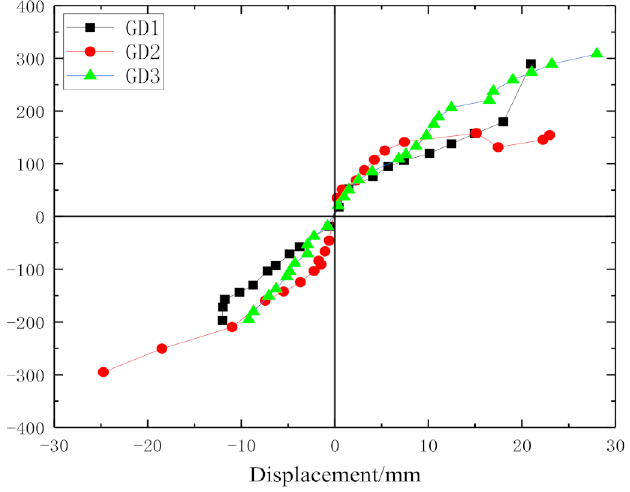
Figure 12. Skeleton